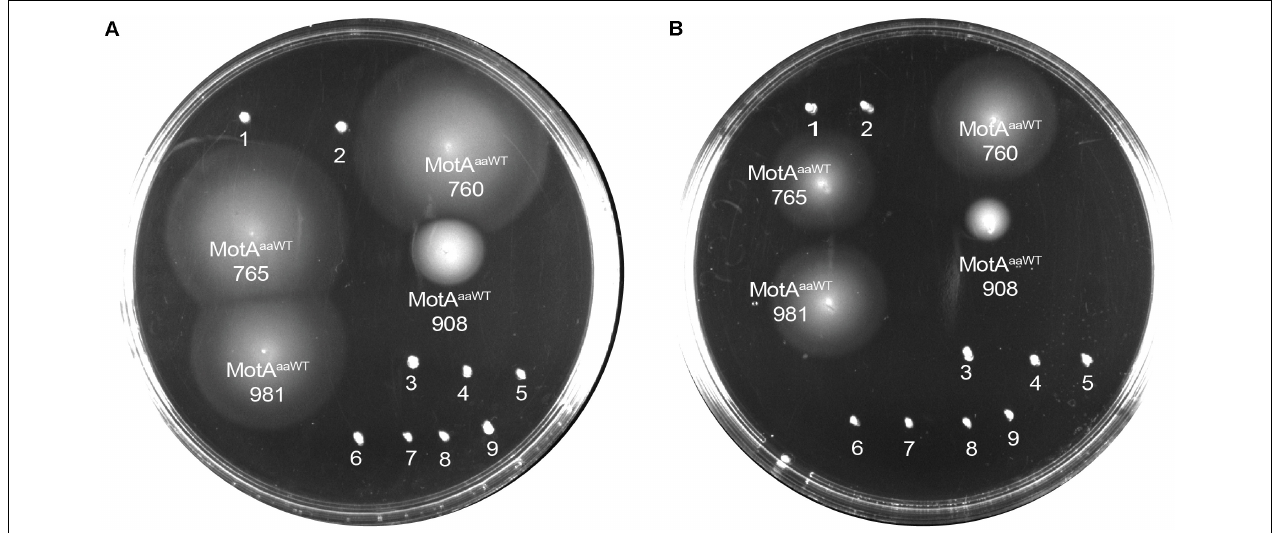
FIGURE 6 | Compatibility of MotB-ASRs with Aquifex aeolicus MotA aaWT on minimal swim plates (with/without NaCl). Of the 13 MotB-ASRs, four restored motility in combination with MotA aaWT in both the presence of Na + (A) and in the absence of Na + (B) . Legend: 1, MotA aaWT MotB-ASR758; 2, MotA aaWT MotB-ASR759; 3,